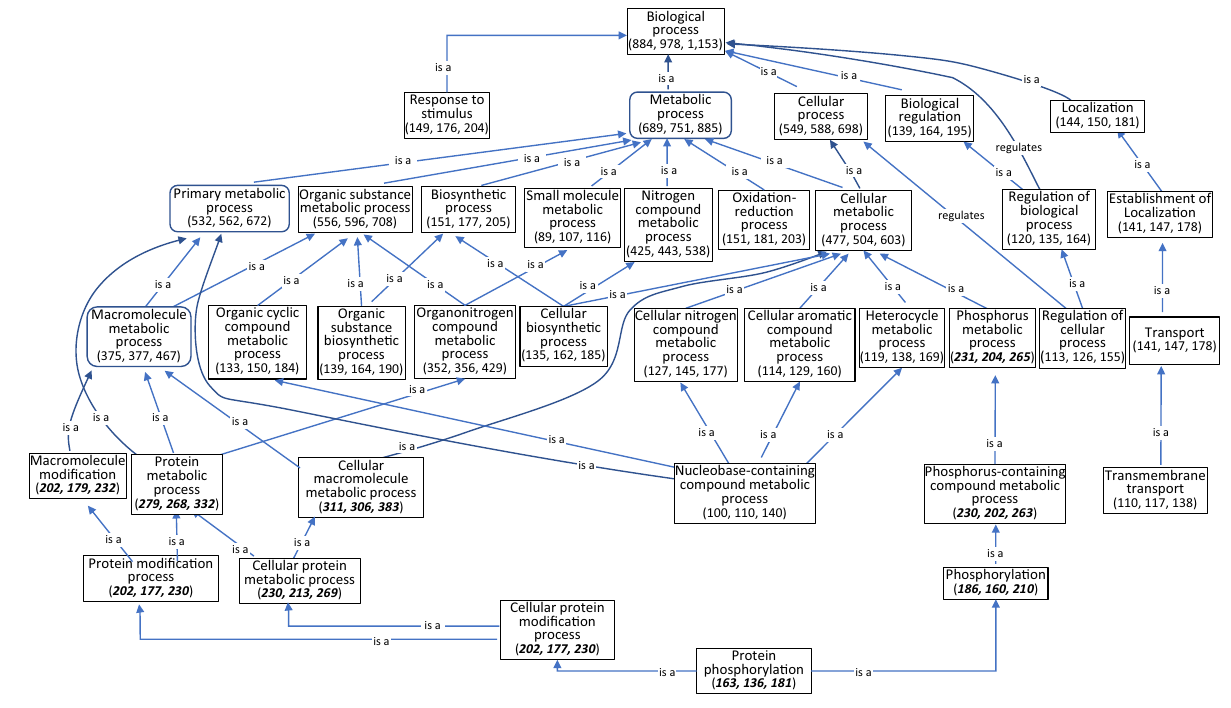
Figure 2. Hierarchical diagram of biological process according to 1153 annotated genes that were differentially expressed under dry and wet conditions in wheat cultivars TAM 111 and TAM 112. Numbers in parenthesis indicate the number of genes in each biological process with the first number indicating genes of TAM 111 followed by those of TAM 112 and the total number of unique genes in both cultivars combined. Numbers in bold and italic font style showed that TAM 111 had a higher number of DEGs for the corresponding biological process, which were different from the majority where TAM 112 had a higher number of DEGs.